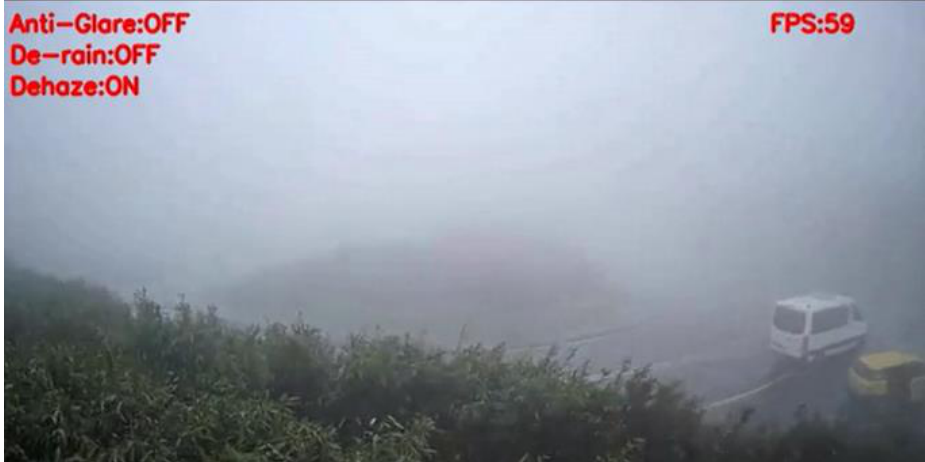
Figure 28. Haze scene image frame detected by YOLOv3.